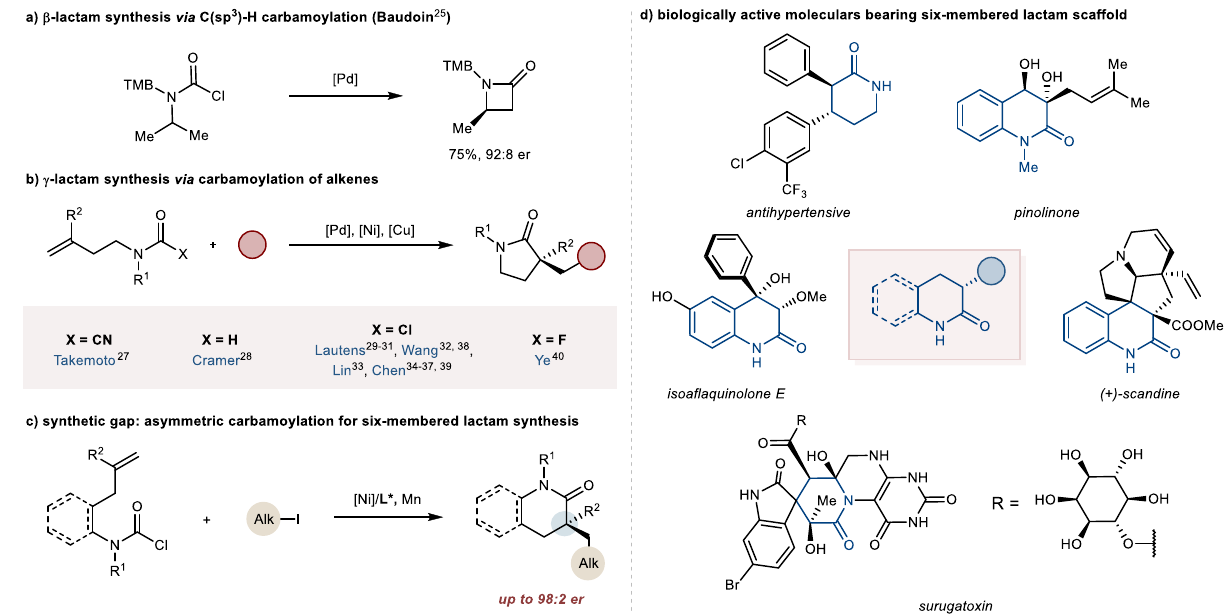
Fig. 1 | Asymmetric carbamoylation for chiral lactam synthesis. a β -Lactam synthesisenabledbytheC(sp 3 )-Hcarbamoylation. b γ -Lactamsynthesisenabledby the carbamoylation of alkenes. c Asymmetric carbamoylation for six-membered-